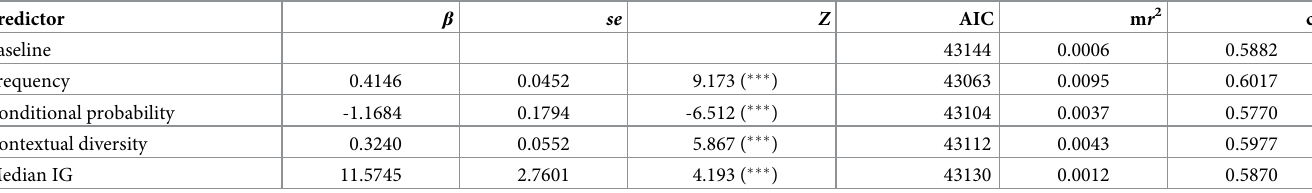
Table 3. Logistic mixed-effect models for single predictors—Numeric overlap